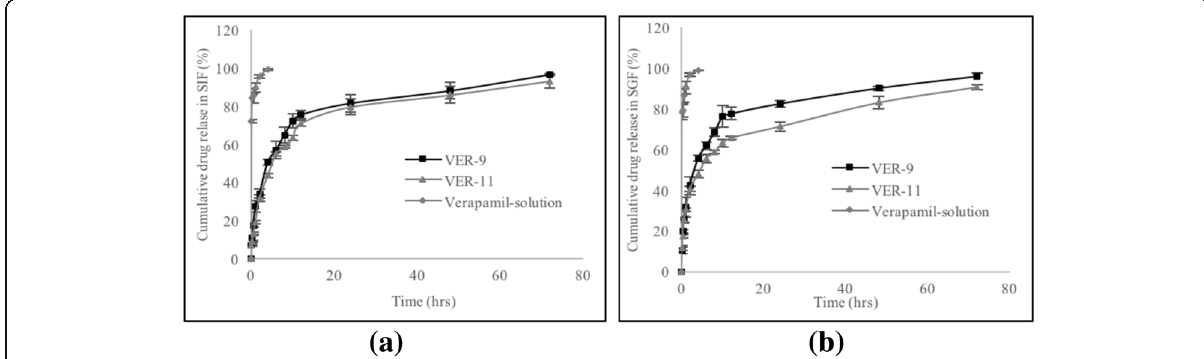
Fig. 7 Cumulative percentage of verapamil released in a SIF (pH 6.8) and b SGF (pH 1.2) release media for 72